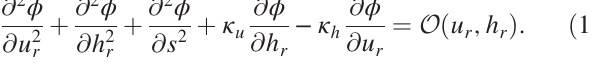
; s Þ plane (left) and in r